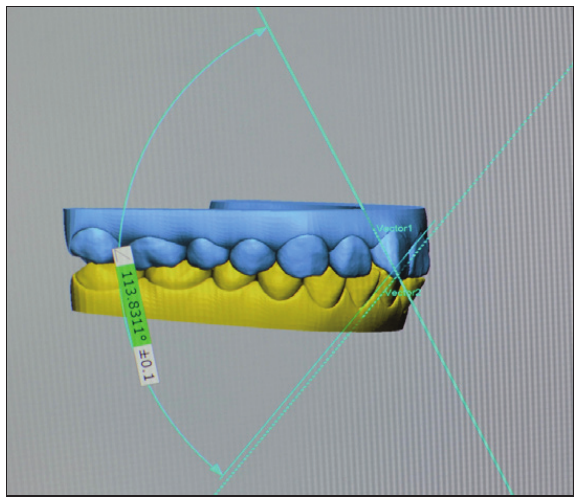
Figure 6. Measurement of interincisal